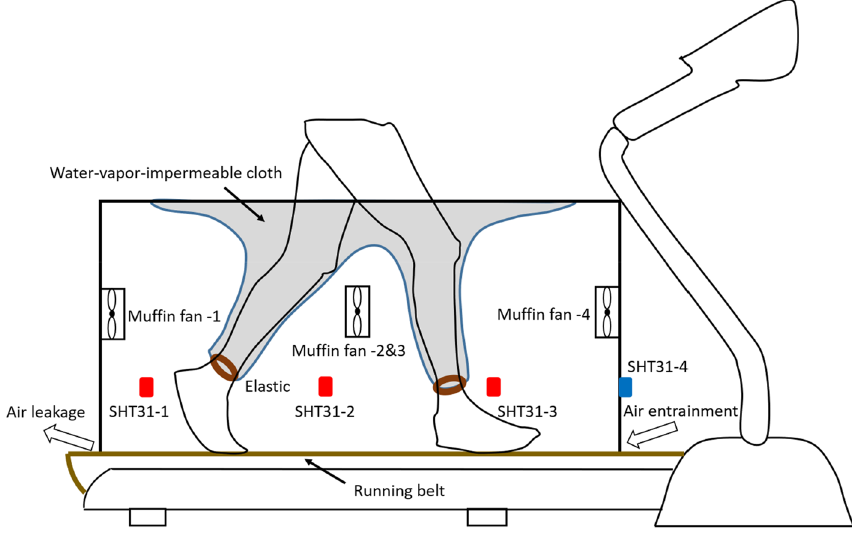
Figure 3. Schematic diagram of the chamber setup for measuring the footwear ventilation